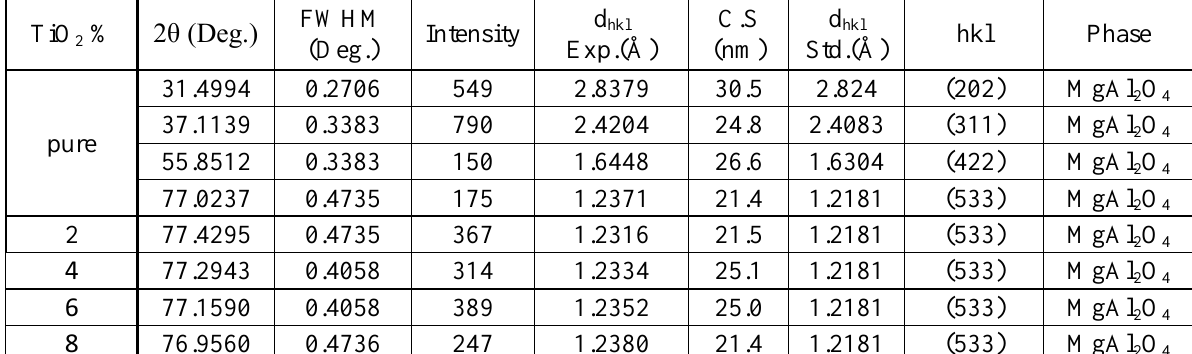
Fig. 1: XRD patterns of sintered specimens at 1200 ° C with different TiO Table 1: The results (XRD) of the samples spinel (MgAl different proportions at a temperature (1200 °